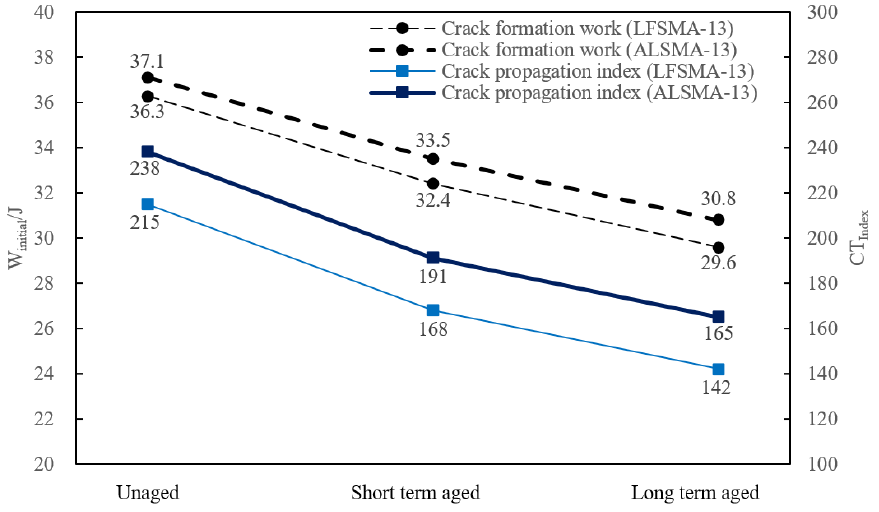
Figure 7. IDEAL-CT test result.